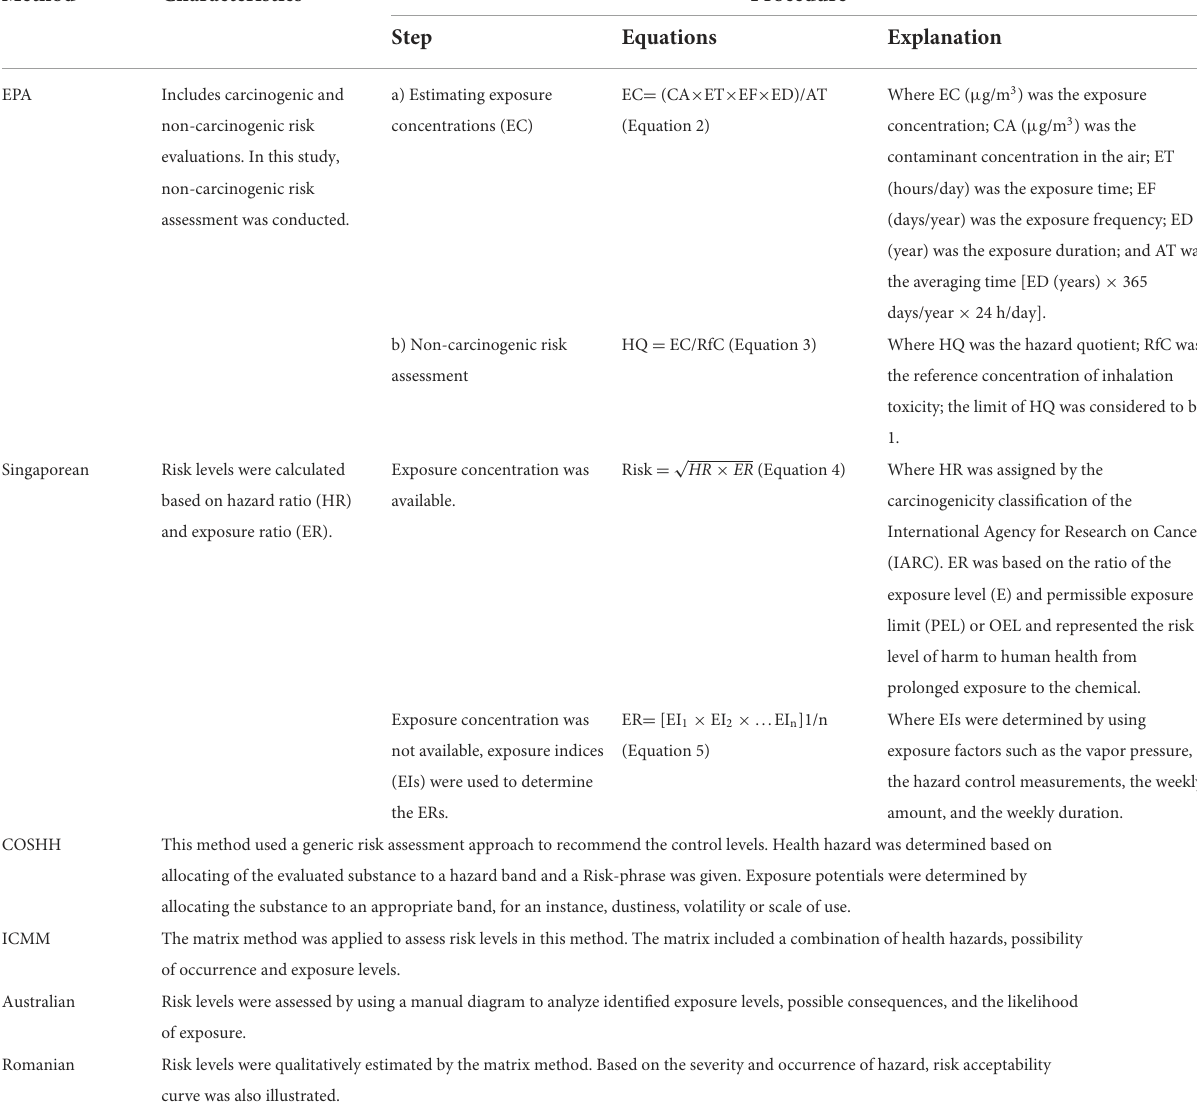
TABLE 1 Brief characteristics of different